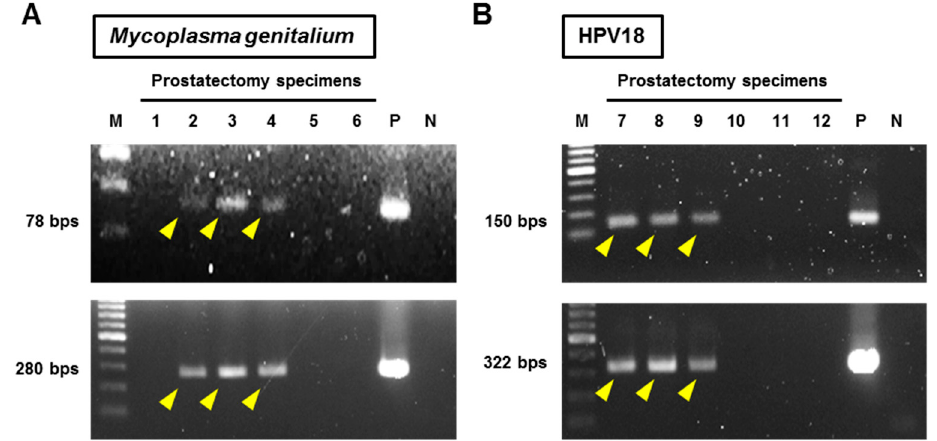
Figure 2. Representative images of PCR for detection of Mycoplasma genitalium and human papillomavirus-18. Patient IDs (1–12) are indicated at the top. ( A ) DNA templates were amplified using two primers (78 bp-amplicon and 280 bp-amplicon) targeting Mycoplasma genitalium , and the PCR products were electrophoresed on agarose gel with ladder markers. Both the primers were defined as positive for Mg (yellow arrowheads). Patients 2–4 were determined positive for Mg. ( B ) Nested PCRs were performed for HPV detection using MY09/MY11 as the outer and GP5+/GP6+ as the inner primers (upper panel). Type-specific PCR to detect HPV18 was performed (lower panel). Both nested PCR and type-specific PCR were defined as positive for HPVs. Patients 7–9 were determined as positive for HPV18. Abbreviations: M: ladder marker, P: positive control, N: negative control,